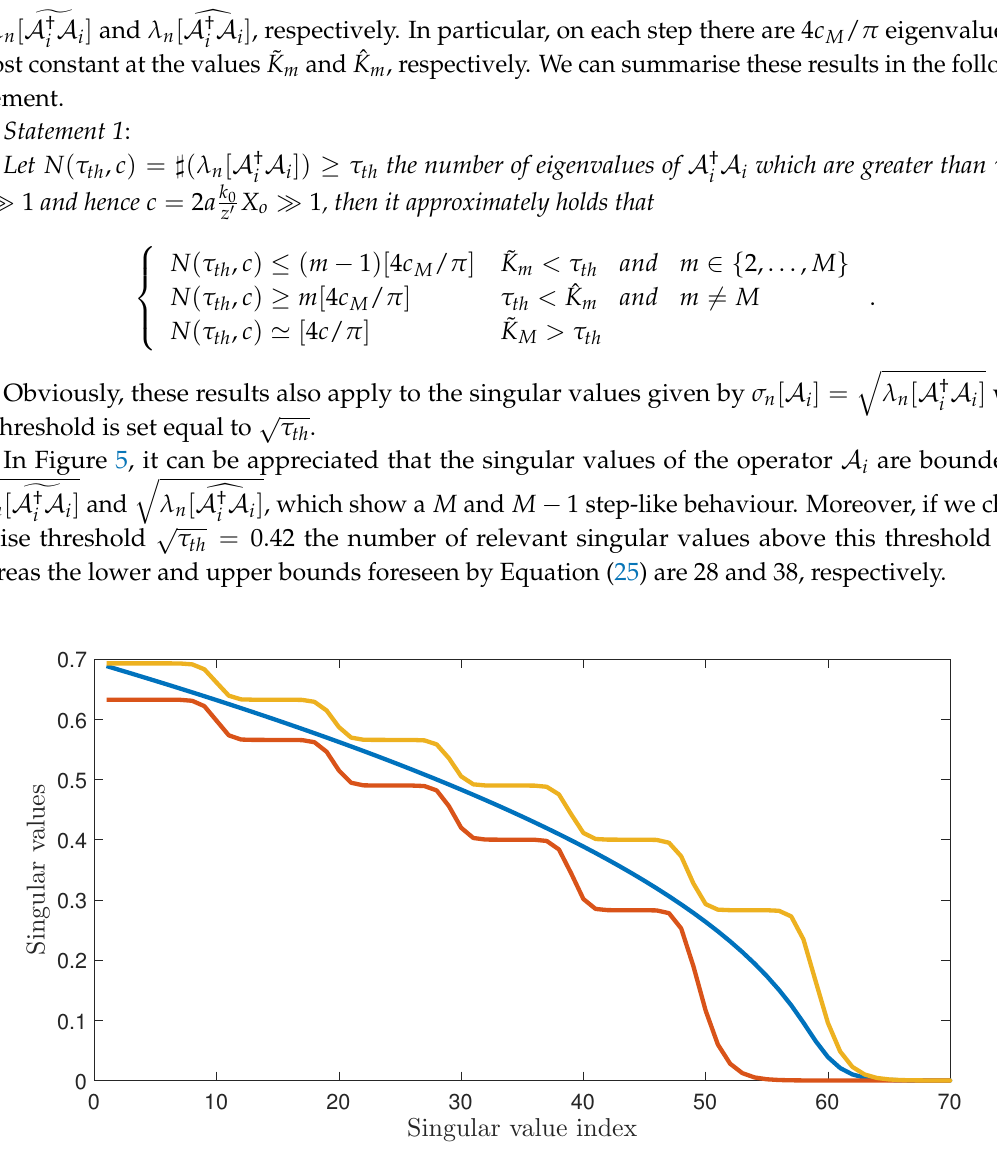
Figure 5. Singular values behaviour of A i for the case of continuous views and 2 M = 12 (the other parameters are set as in Figure 2). Yellow and red lines represent the square root of the eigenvalues of (cid:101) A † i A i and (cid:98) A † i A i ,